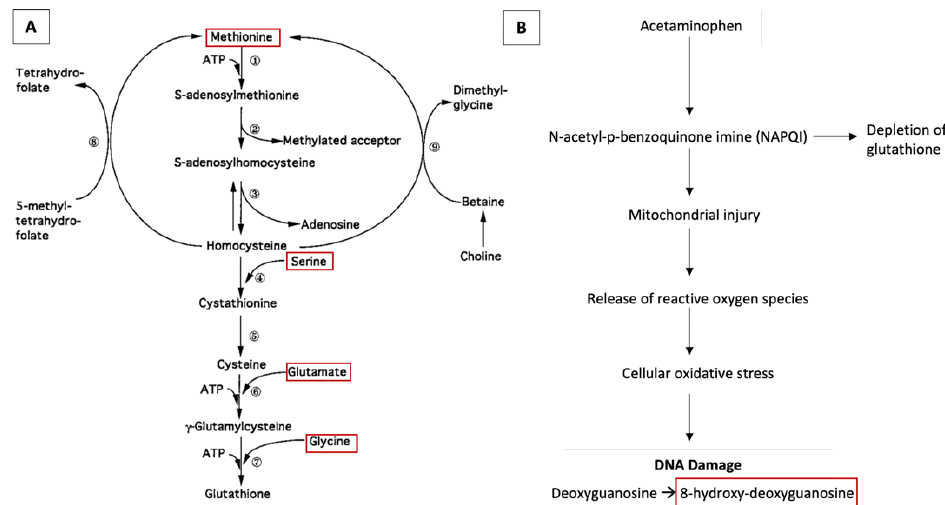
Figure 1. Pathways for synthesis of antioxidant glutathione ( A ) a and acetaminophen toxicity leading to oxidative stress ( B ) b,c . a Figure adapted with permission from Lu, S. C. (1999) [29]. Regulation of hepatic glutathione synthesis: current concepts and controversies. FASEB J, 13 (10), 1169–1183. b Figure based on Scheme 1 from C. L. Powell et al. [32], “Phenotypic anchoring of acetaminophen- induced oxidative stress with gene expression profiles in rat liver,” (in eng), Toxicol Sci, vol. 93, no. 1, pp. 213–22, Sep 2006, doi:10.1093/toxsci/kfl030. c Selected analytes for study boxed in